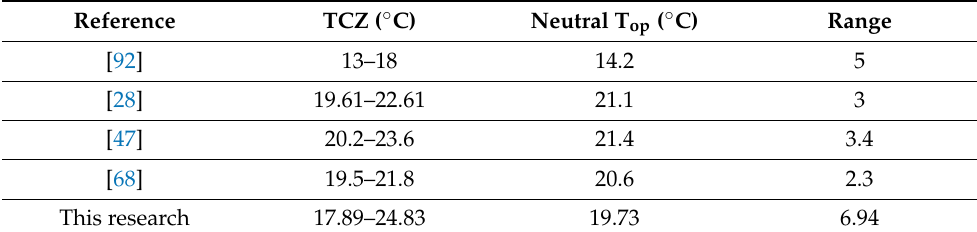
Table 11. TCZ developed for winter in other